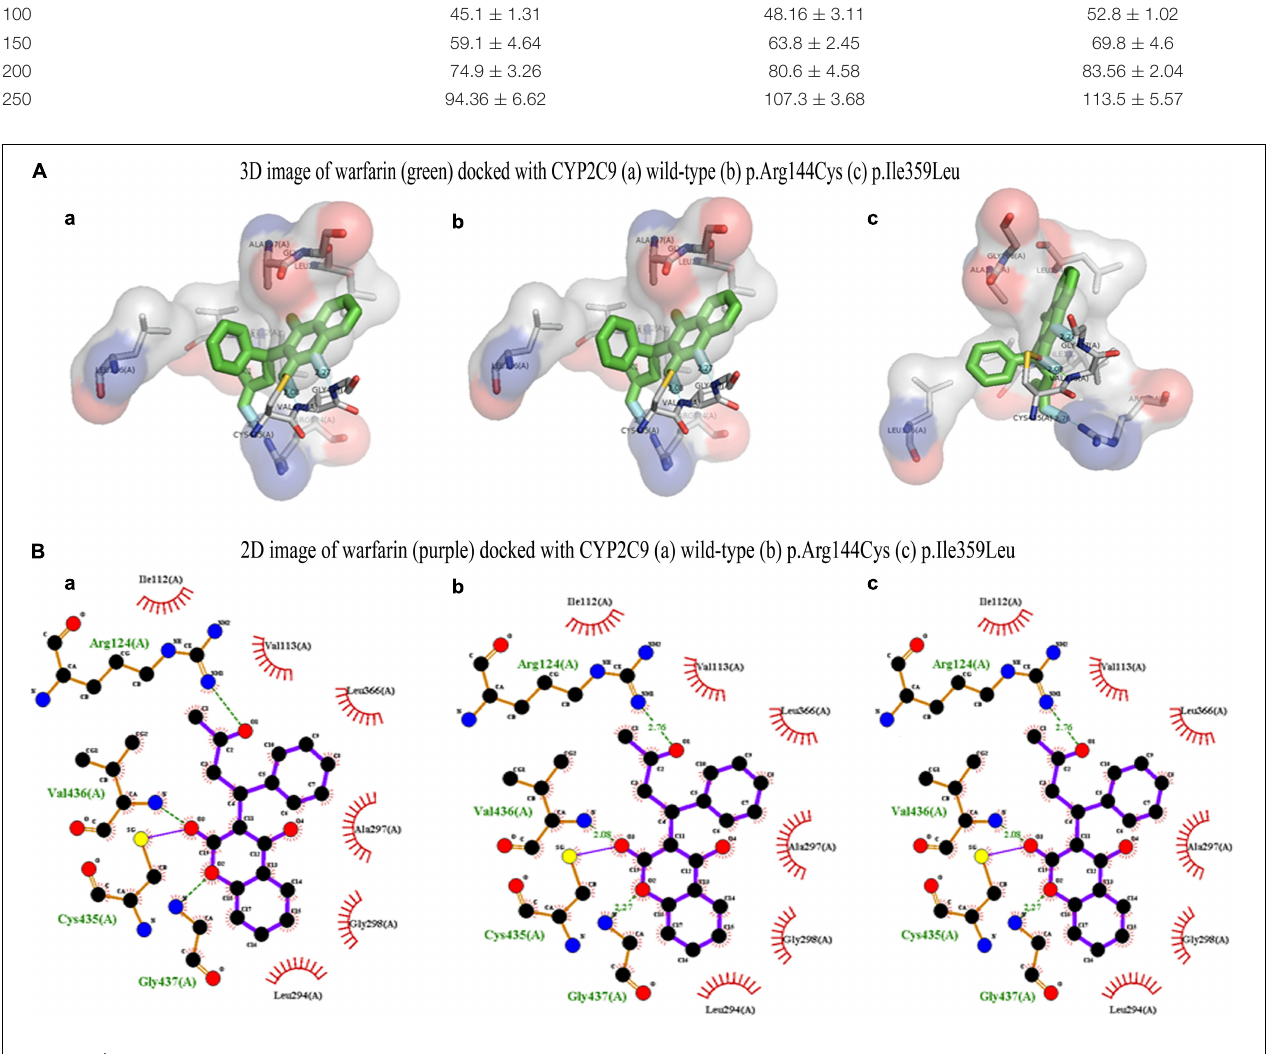
FIGURE 8 | (A) 3D image of warfarin (green) docked with CYP2C9 (a) wild type, (b) p.Arg144Cys , and (c) p.Ile359Leu. (B) 2D image of warfarin (purple) docked with CYP2C9 (a) wild type, (b) p.Arg144Cys , and (c)